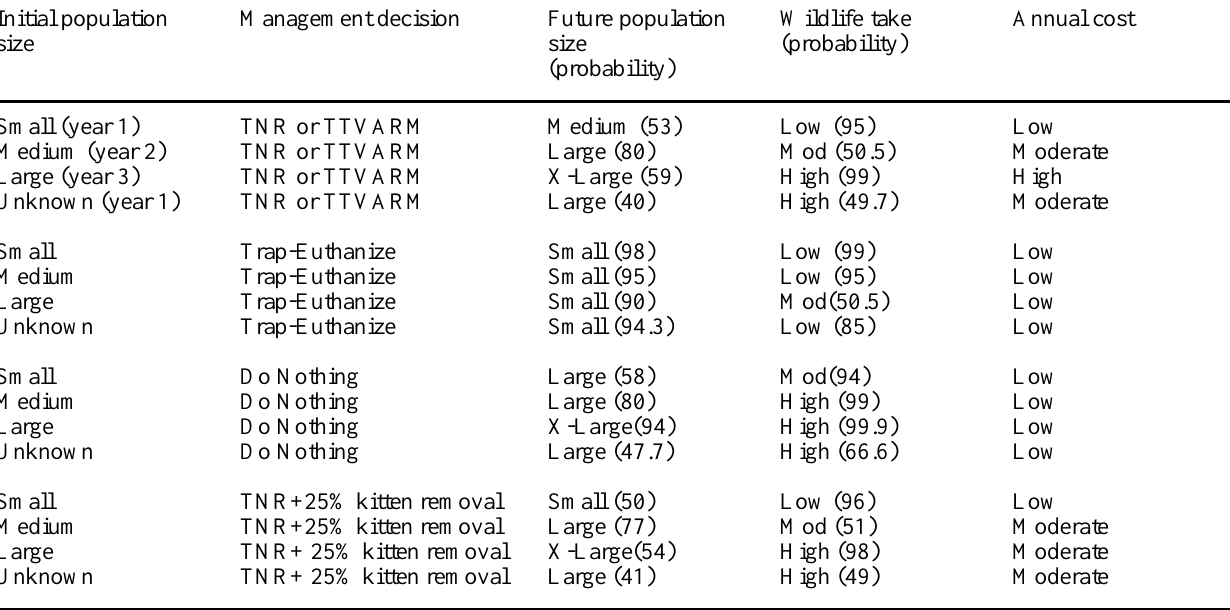
Table 7 . The expected cost and probabilities of future population size and wildlife take under alternative management strategies for Small, Medium, Large and Unknown future population